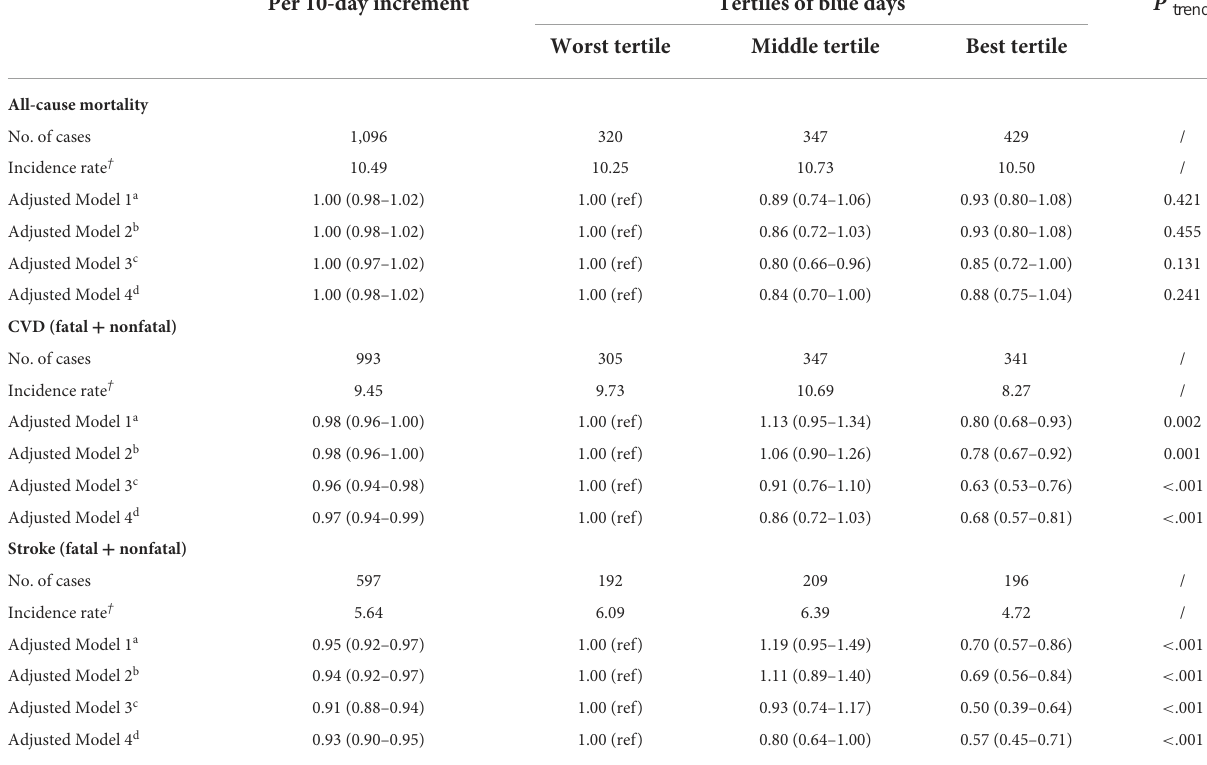
TABLE 2 Hazard ratios (95% CIs) for chronic blue day exposure with all-cause mortality and cardiovascular events. Per 10-day increment Tertiles of blue days P trend Worst tertile Middle tertile Best